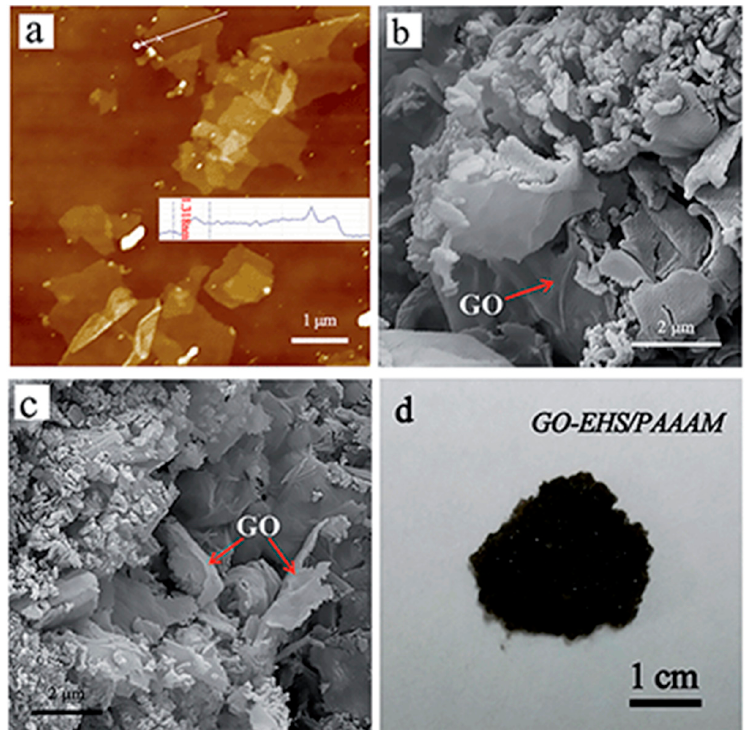
Figure 4. SEM images of graphene oxide nanoparticles used in hydrated salt PCM ( a ) AFM image and height of graphene oxide, ( b , c ) SEM images of graphene oxide—EHS/PAAAM, and ( d ) unen- hanced image of graphene oxide—EHS/PAAAM mixture. (Reprinted with permission from ref. [38]. Copyright 2013 Royal Society of Chemistry).